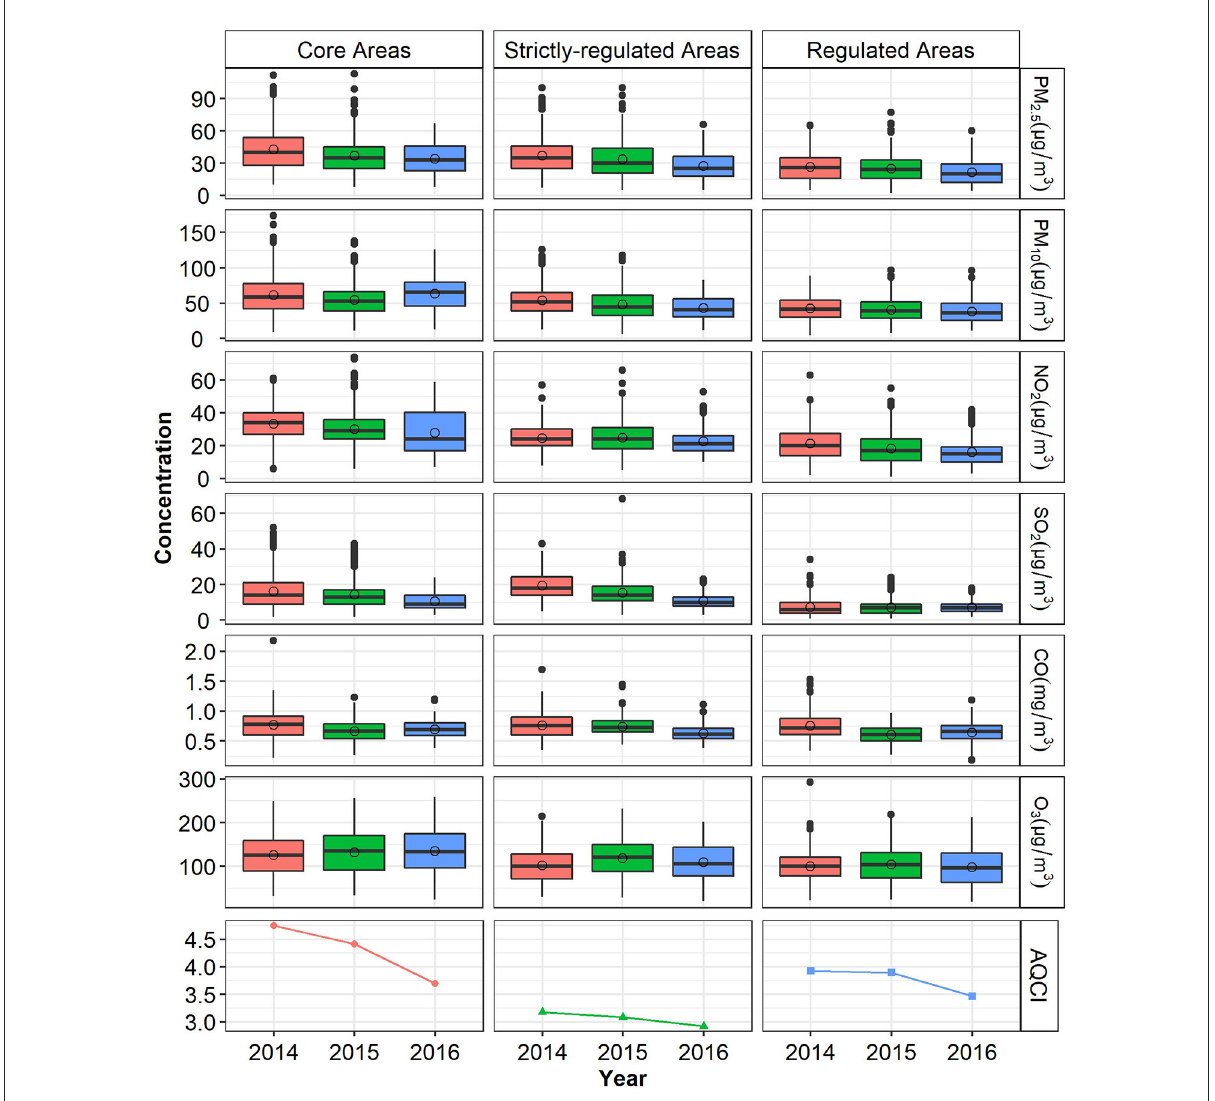
FIGURE2 AQCI and main air pollutants concentration before and during the G20 period. Time span: July–September. The open circle represents the mean.